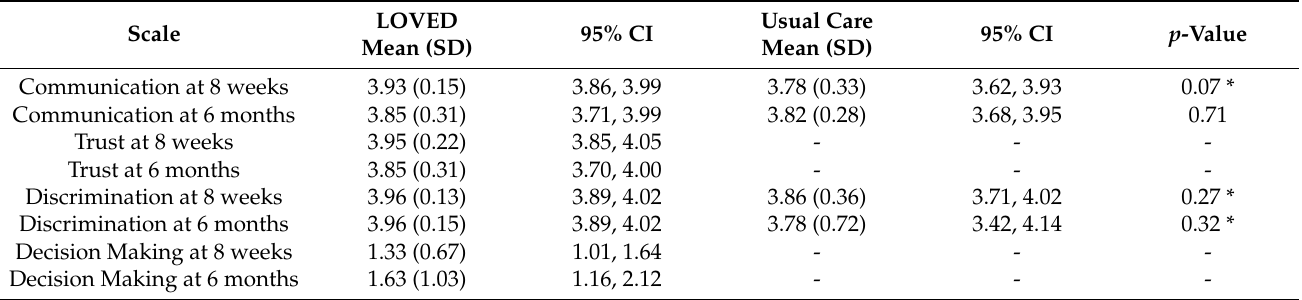
Table 4. Cultural competency questionnaire